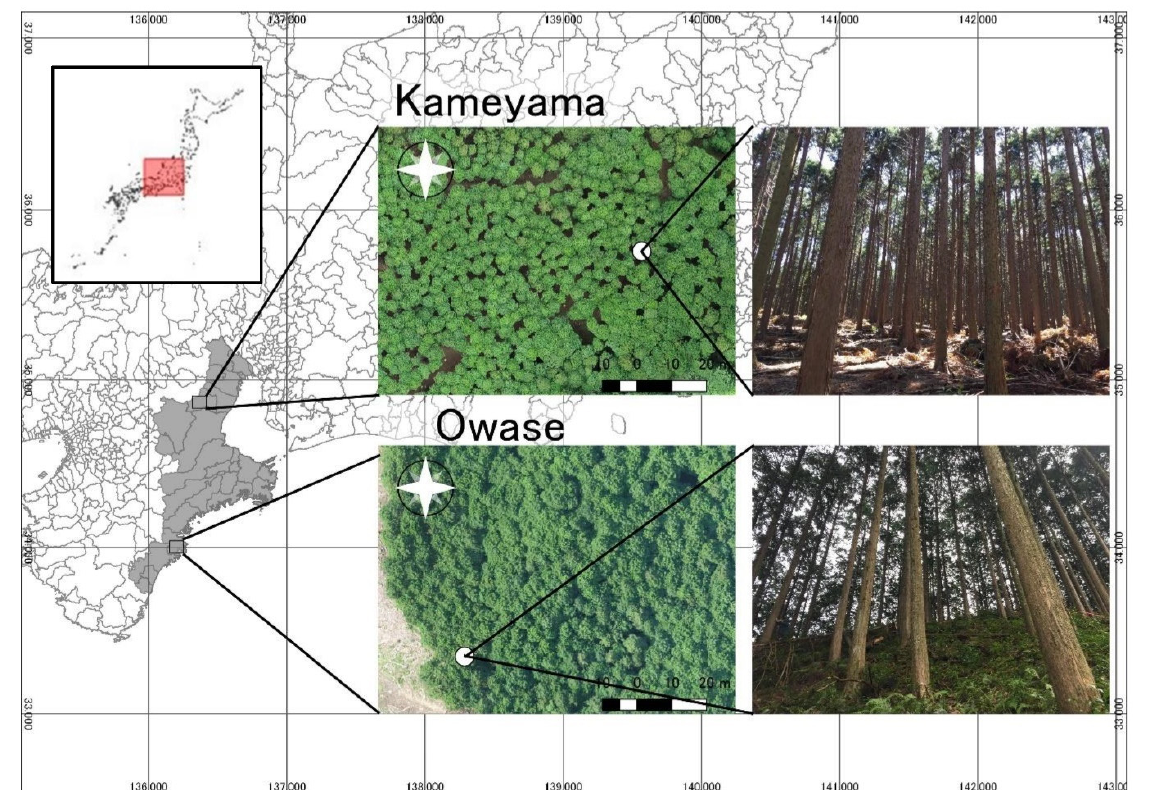
Figure 1. An illustration of the location and forest appearance of study sites from the air and the field. The frame embedded on the upper left shows the whole area of Japan, and the red box in the frame highlights central Japan, where the study sites are located. The grid marks on the map reveal